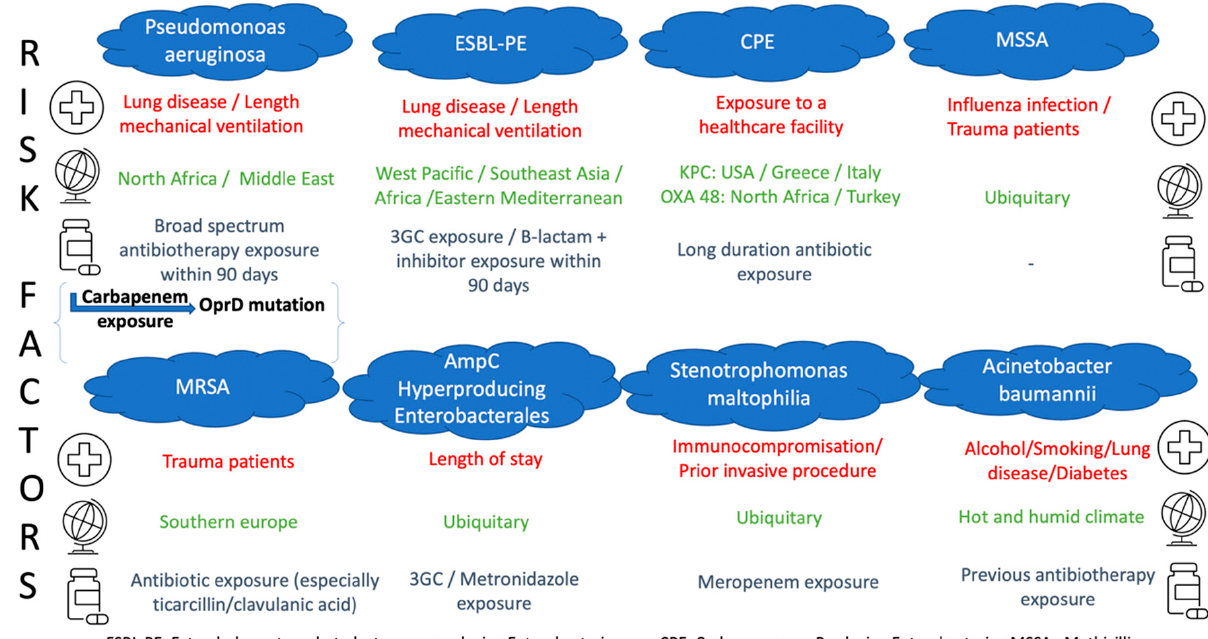
Figure 2. Risk factors for MDRO-related infections.